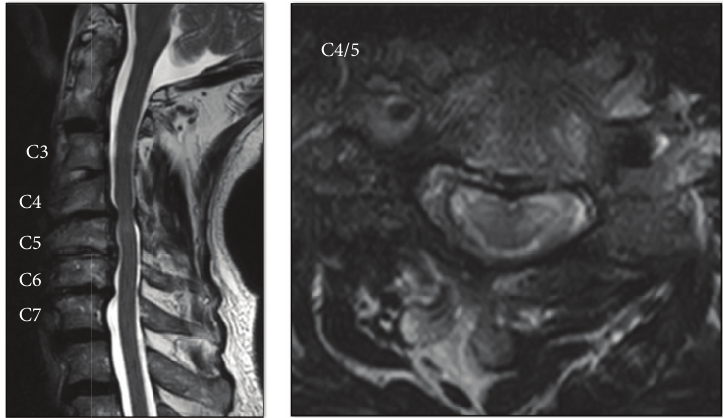
Figure 1: Magnetic resonance image showing C3–C7 degenerative spondylosis with mild central canal stenosis and high-signal lesions at